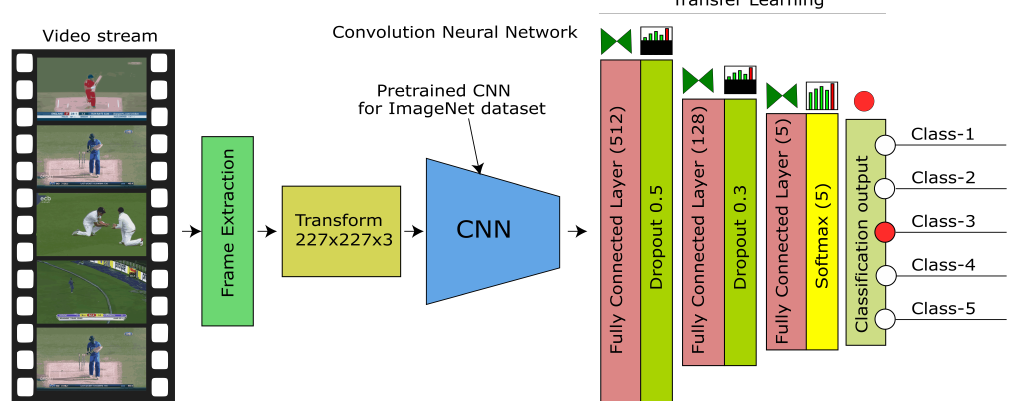
Figure 1. The proposed model architecture. Input video is extracted into frames and key frames are classified by a trained CNN. Output class identifies the scene and is compared if continuous